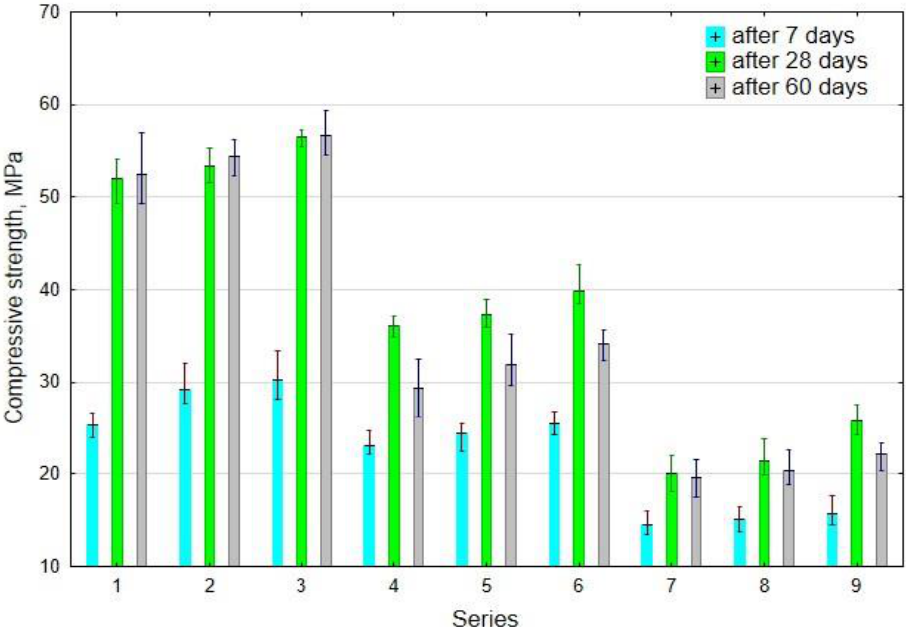
Figure 9. The average test results of the compressive strength of geopolymer mortars containing hemp after 7, 28, and 60 days.